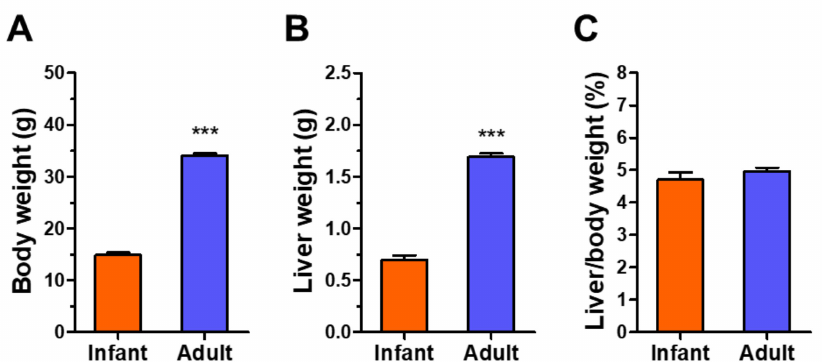
Figure 1. Body and liver weights and the ratio of liver/body weight of infant (3-week-old, n = 9) and adult (9-week-old, n = 9) male mice: ( A ) Body weight; ( B ) Liver weight; ( C ) Liver/body weight ratio. Data are presented as mean ± SE. Student’s t -test, *** p < 0.001, vs. infant.